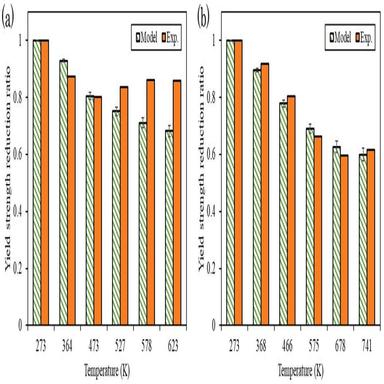
YS reduction ratio for strain-rates (a) 0.1 s − 1 and (b) 450 s − 1 across a range of temperatures: comparison of experimental (published) data for S35C steel from Alhassani with model predictions.